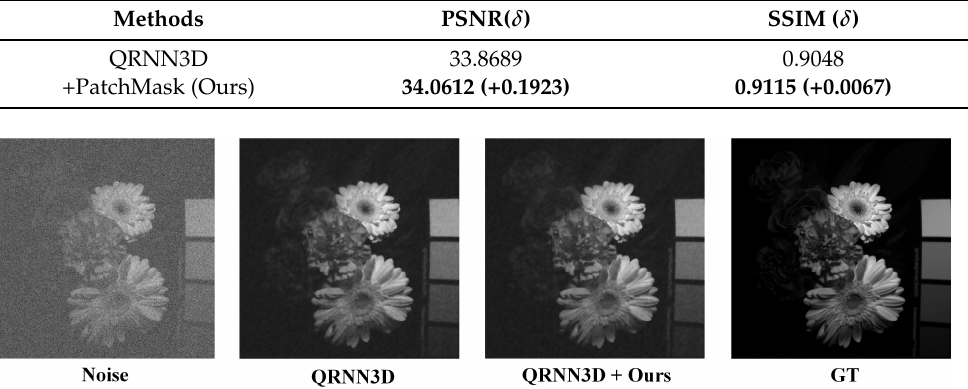
Figure 8. Here, we have selected the 24th band to demonstrate the effect of the method on the CAVE